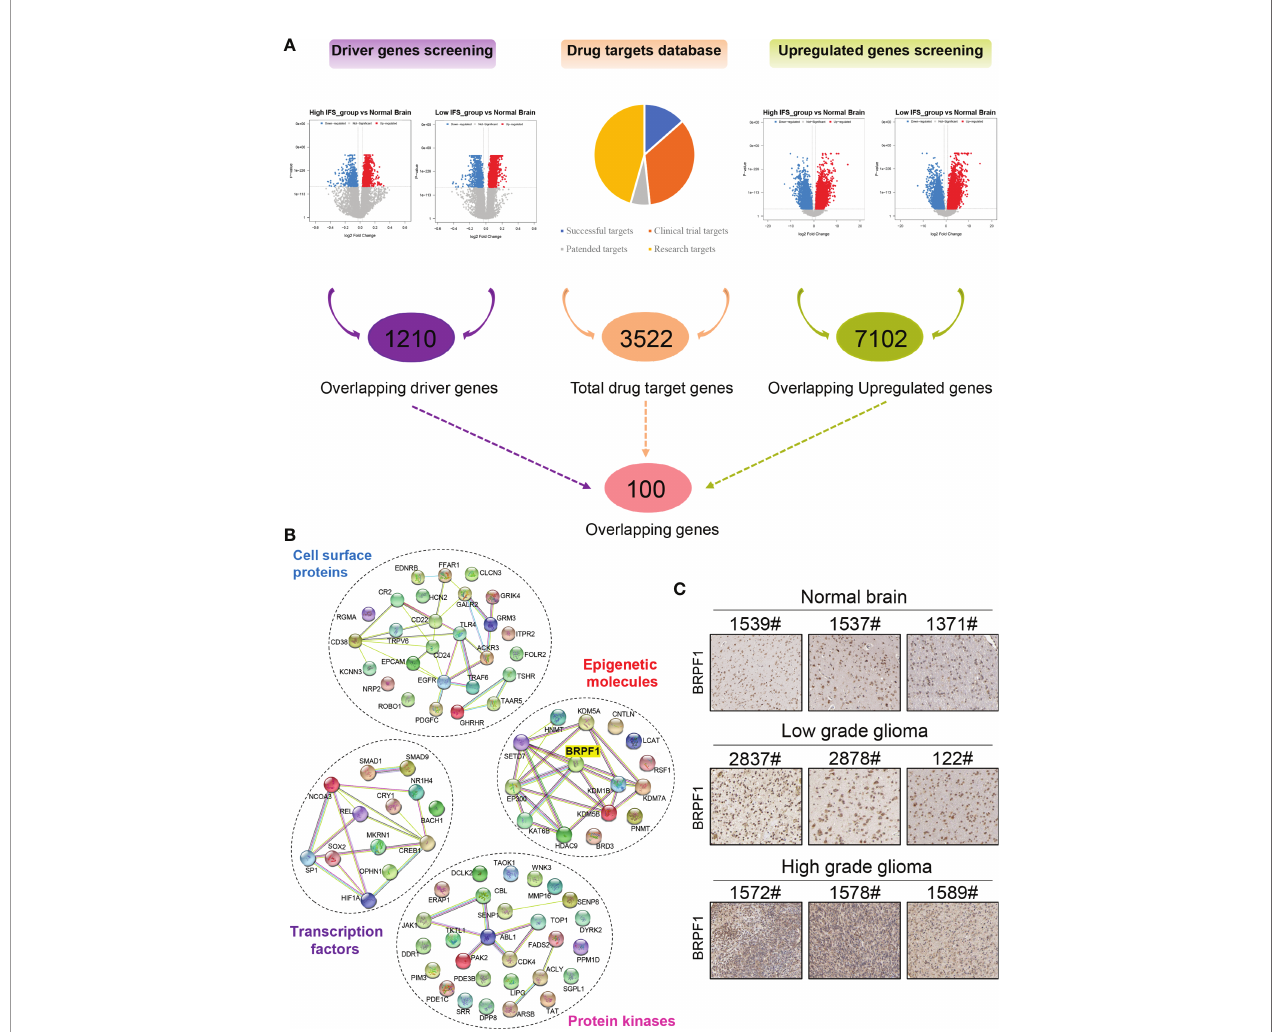
FIGURE 6 | Screening of drug targets based on the in fl ammatory signature. (A) Screening fl owchart of potential drug targets based on the transcriptome data between the normal brain and the high- or low-in fl ammatory signature groups. (B) The protein-protein interaction network of the following four categories: transcription factors, epigenetic molecules, protein kinases, and cell surface proteins. (C) The protein level of BRPF1 in normal brain, low-grade glioma and high- grade glioma tissues from the Human Protein